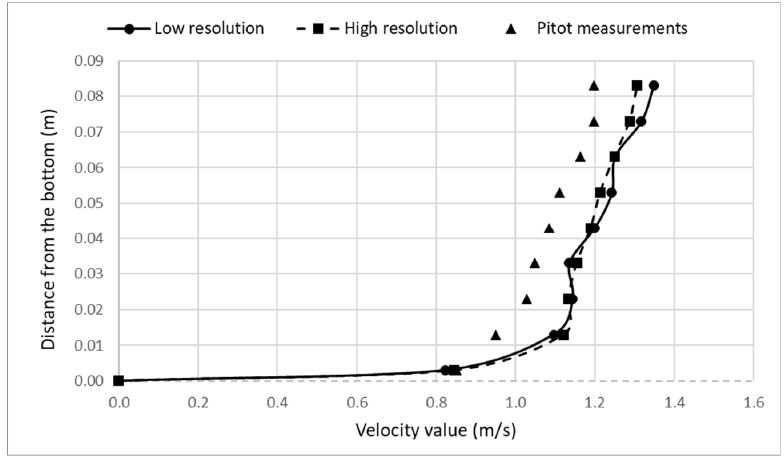
Figure 11. Comparison between the hydrodynamics resulting from the numerical model (for both the tested grid resolutions) and the physical model.